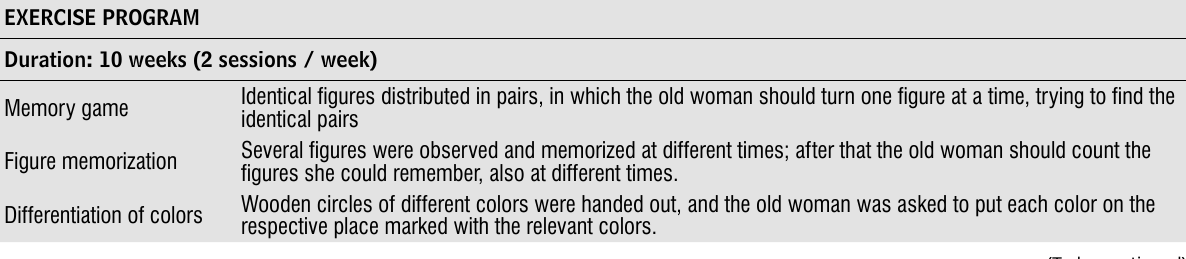
Table 1 – Cerebral gymnastics exercise program EXERCISE PROGRAM